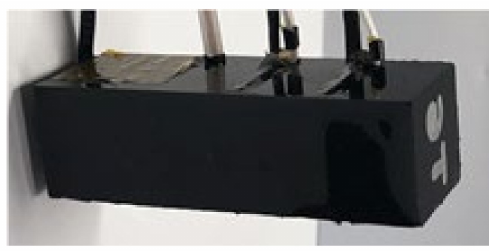
Figure 2. Single smart skin